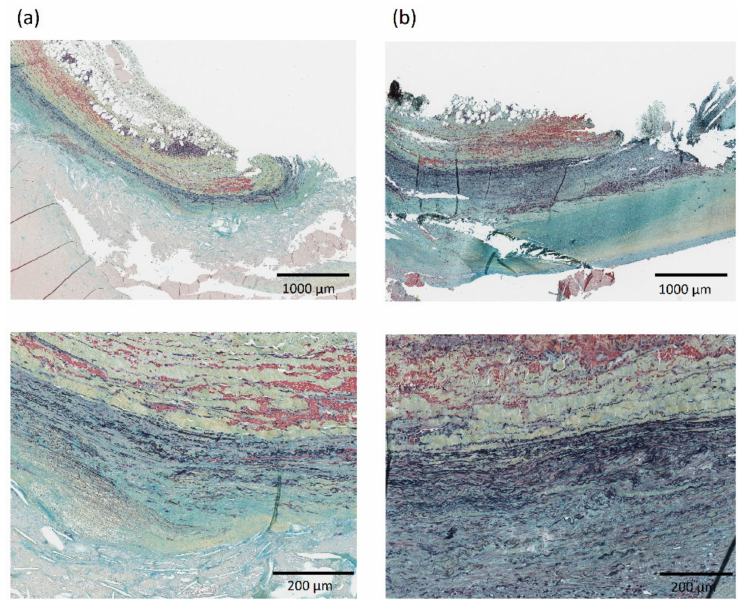
Figure 4. Representative histology showing aortic composition visualized with Musto/Movat pentachrome stain in the neck—region RA1 (column a ) and aneurysmal dilatation—region LA3 (column b ) for one AAA patient in the population. The layers in each histology from top to bottom are: adventitia, media, and intima. Images at 2 × (top) and 10 × (bottom) magnification are shown.